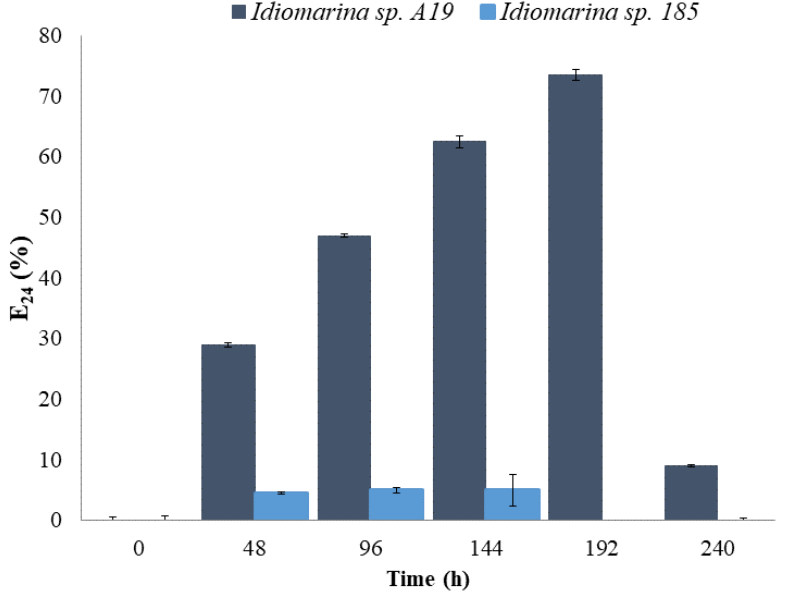
Figure 1. Production of stable emulsion by Idiomarina sp. A19 and Idiomarina sp. 185 during incubation in Marine Broth at 15 °C and pH 7.6.